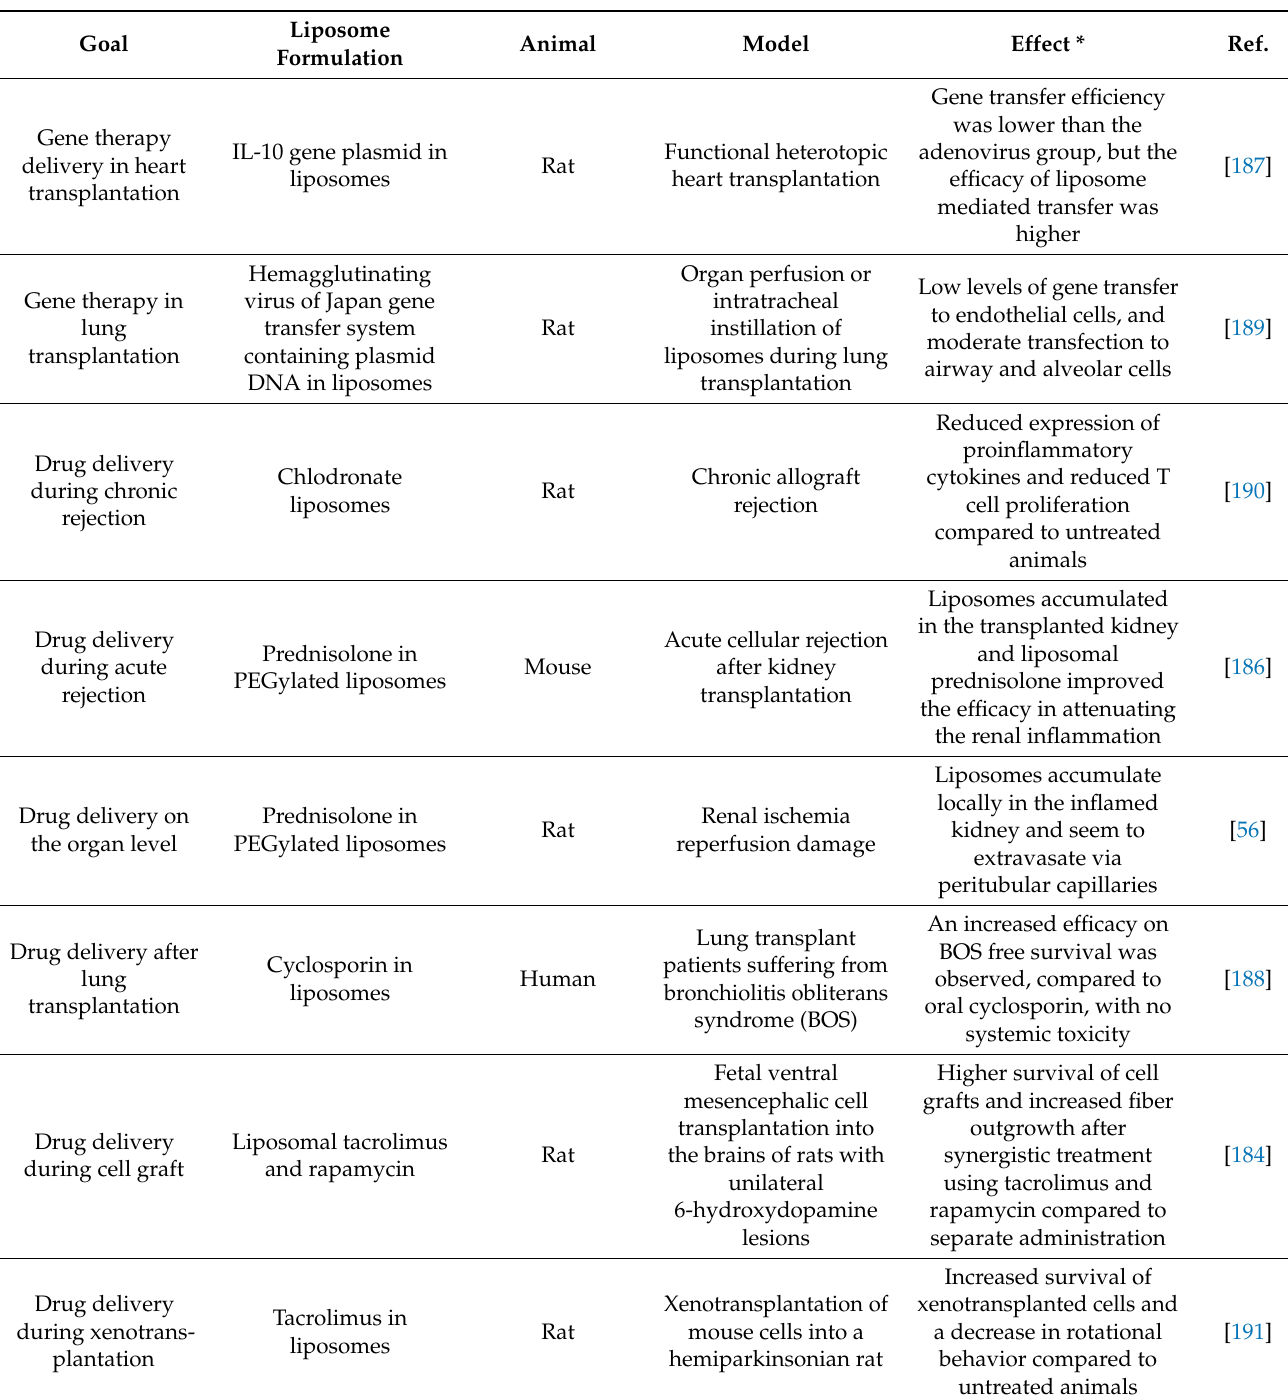
Table 4. Overview of innovative research using liposome-based drug delivery in organ transplantation.